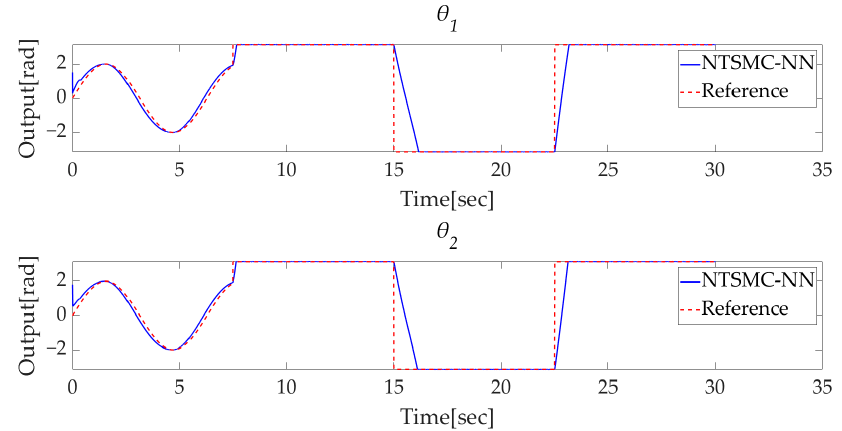
Figure 17. NTSMC-NN controller performance for mixed input.